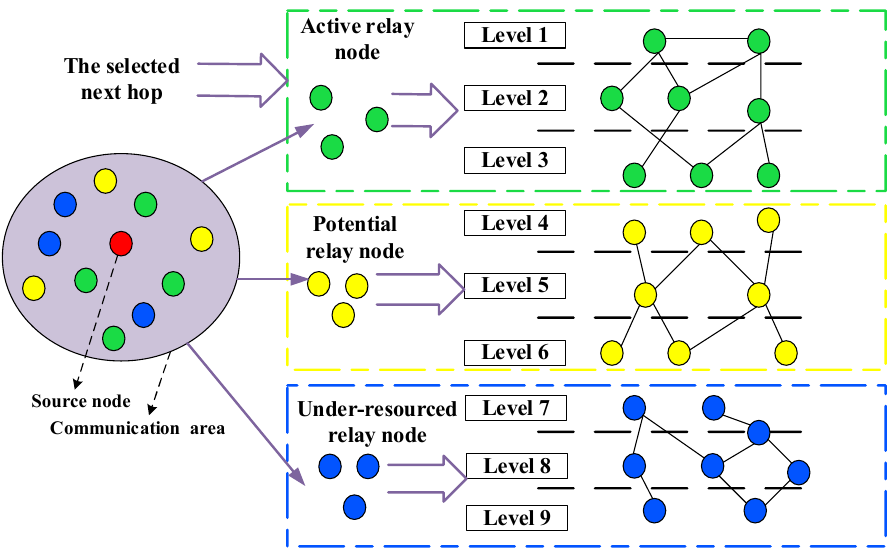
Figure A2. Fuzzy inference and node classification based on “If-Then” rules from the CMFI system.